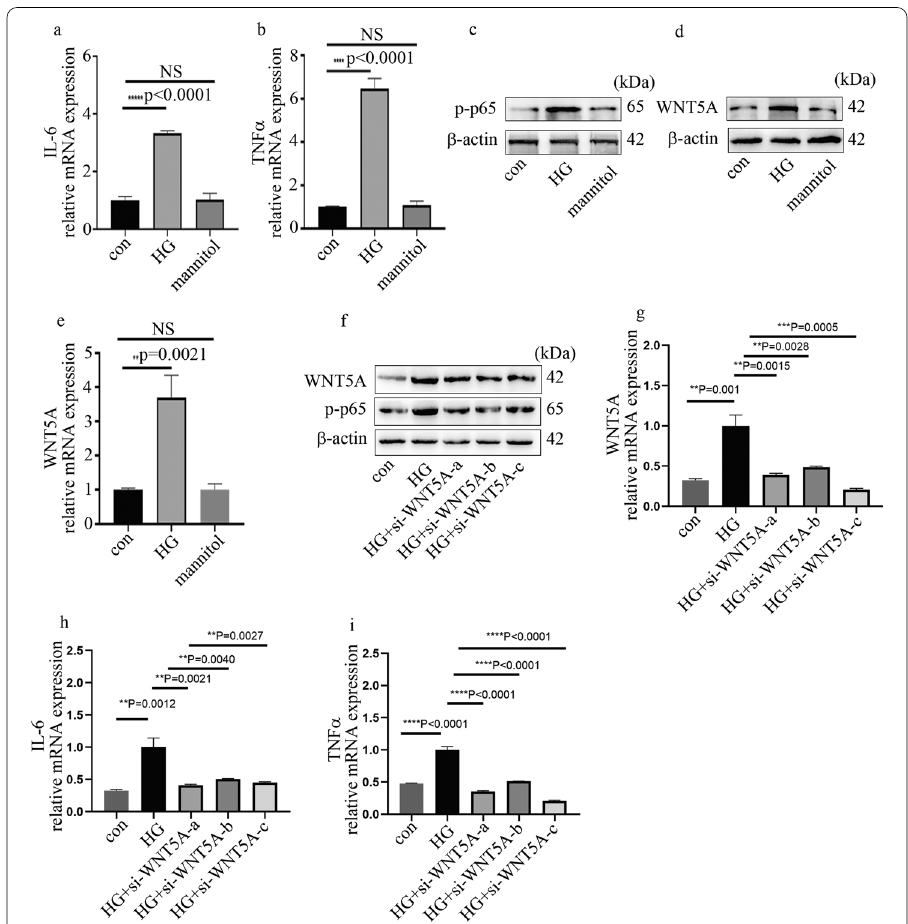
Fig. 2 High-glucose-induced inflammatory factors and p-p65 expression was reversed by si-WNT5A. a , b mRNA expression of IL-6 and TNFα in HGECs. c , d Western blot analysis of p-p65 and WNT5A in HGECs. e mRNA expression of WNT5A in HGECs. f Western blot analysis of p-p65 and WNT5A in HGECs. g – i mRNA expression of WNT5A, IL-6, and TNFα in HGECs (* p < 0.05, ** p < 0.01, *** p < 0.001, **** p < 0.0001, n